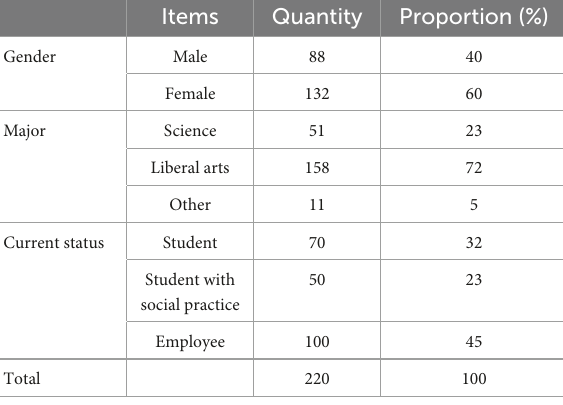
TABLE 2 Descriptive statistics of the